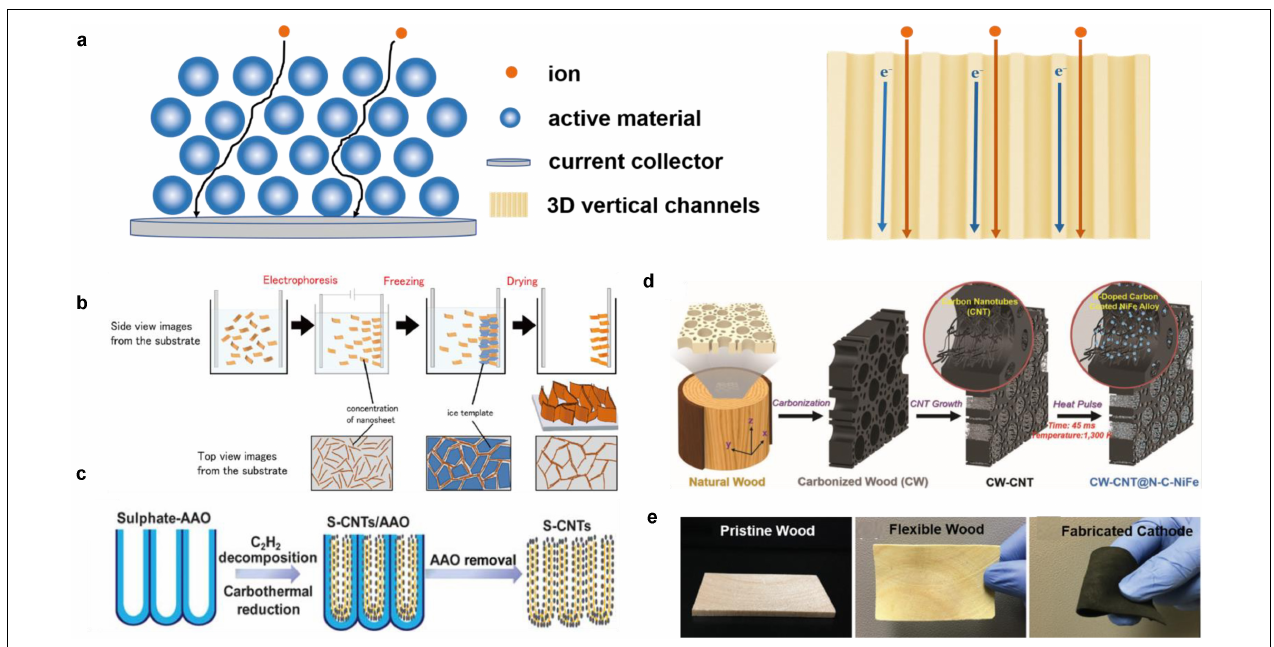
FIGURE 1 | (a) Schematic illustration of the different configurations of electrode materials: fabricate electrodes by slurry-casting process (left) and 3D-OPC electrodes (right). (b) Formation mechanism of the vertically aligned film by electrophoresis and freeze-drying (source: Mochizuki et al., 2019). Reproduced by permission of American Chemical Society https://doi.org/10.1021/acsaem.8b01478. (c) Thermal decomposition of C 2 H 2 in a sulfate-containing AAO template and the formation of S-CNTs after AAO removal (source: Zhou et al., 2012). Reproduced by permission of Royal Society of Chemistry https://doi.org/ 10.1039/C2EE22294A. (d) The fabrication process of the CW-CNT@N-C-NiFe electrode (source: Li Y. et al., 2018). Reproduced by permission of WILEY-VCH Verlag GmbH & Co. KGaA, Weinheim https://doi.org/10.1002/aenm.201801289. (e) Photos of the pristine wood, the flexible wood, and the flexible cathode with the CNT coating and Ru (source: Xu et al., 2018). Reproduced by permission of Royal Society of Chemistry